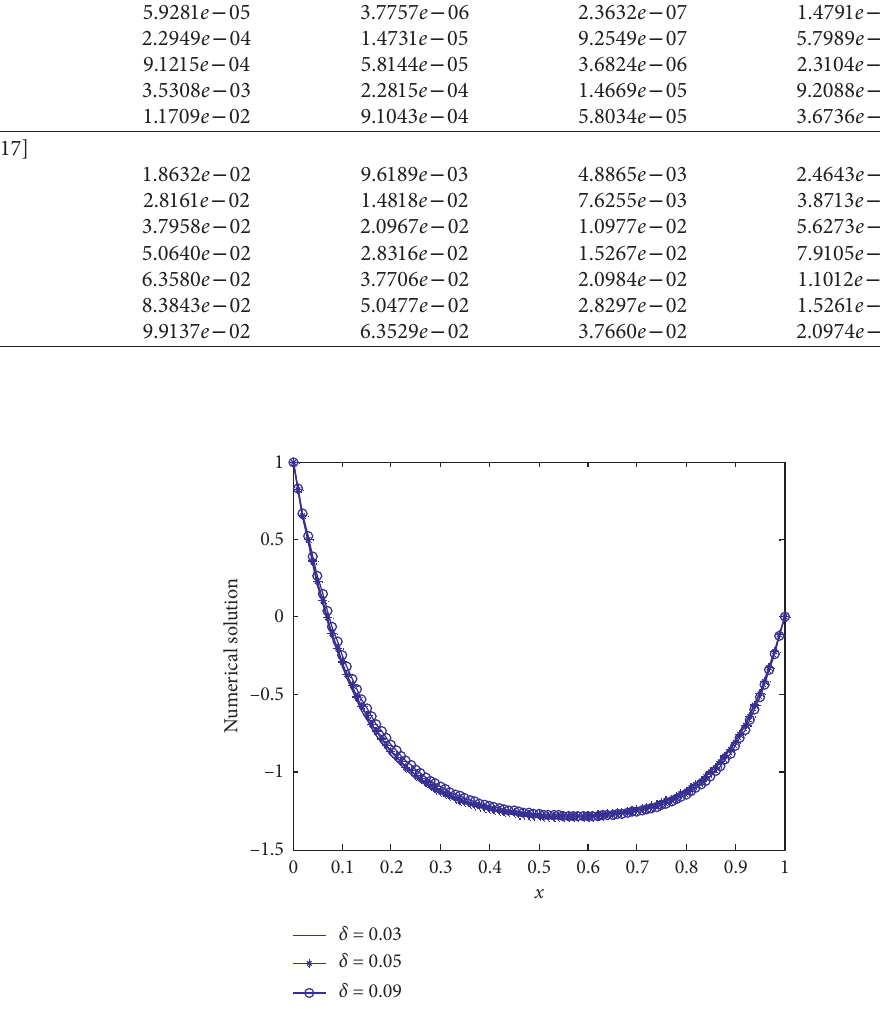
Figure 1: The numerical solution of Example 1 with ε � 0 . 01 and N �